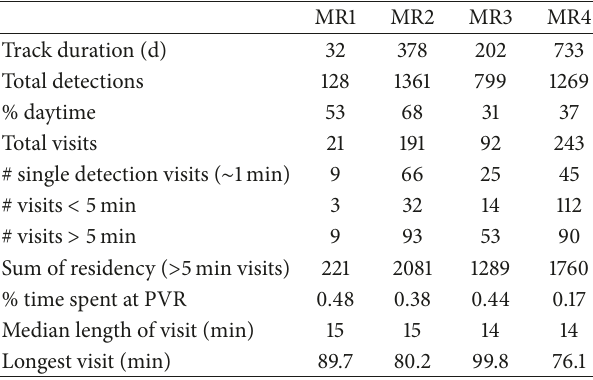
Table 2: Summary of acoustic detection for 4 M. ramsayi individu- als detected at